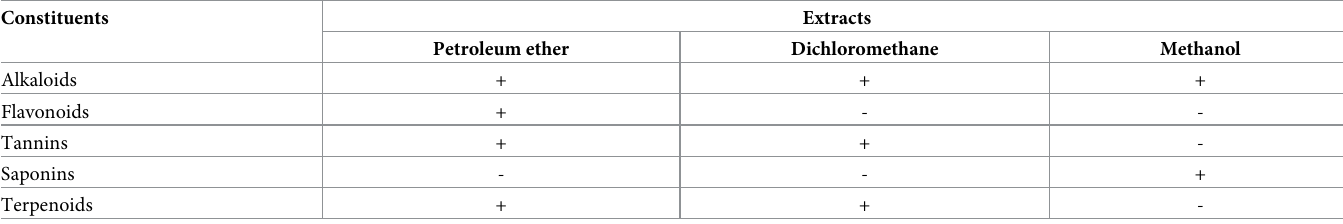
Table 4. Phytochemical screening of the different Eucalyptus grandis extracts that showed antimicrobial activity on the selected